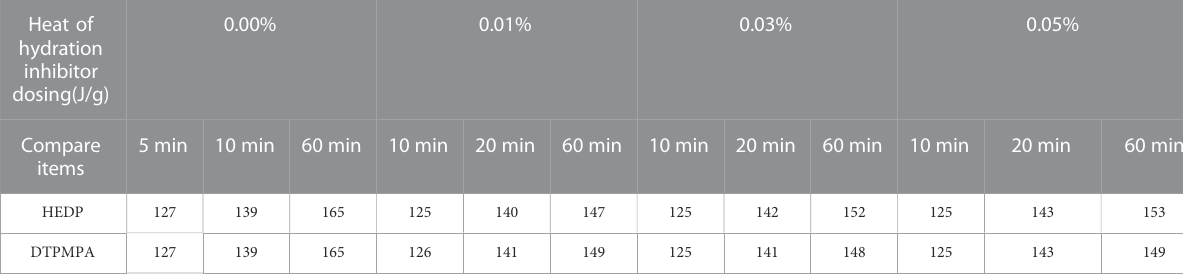
TABLE 8 C 3 A cumulative hydration heat release data over various time